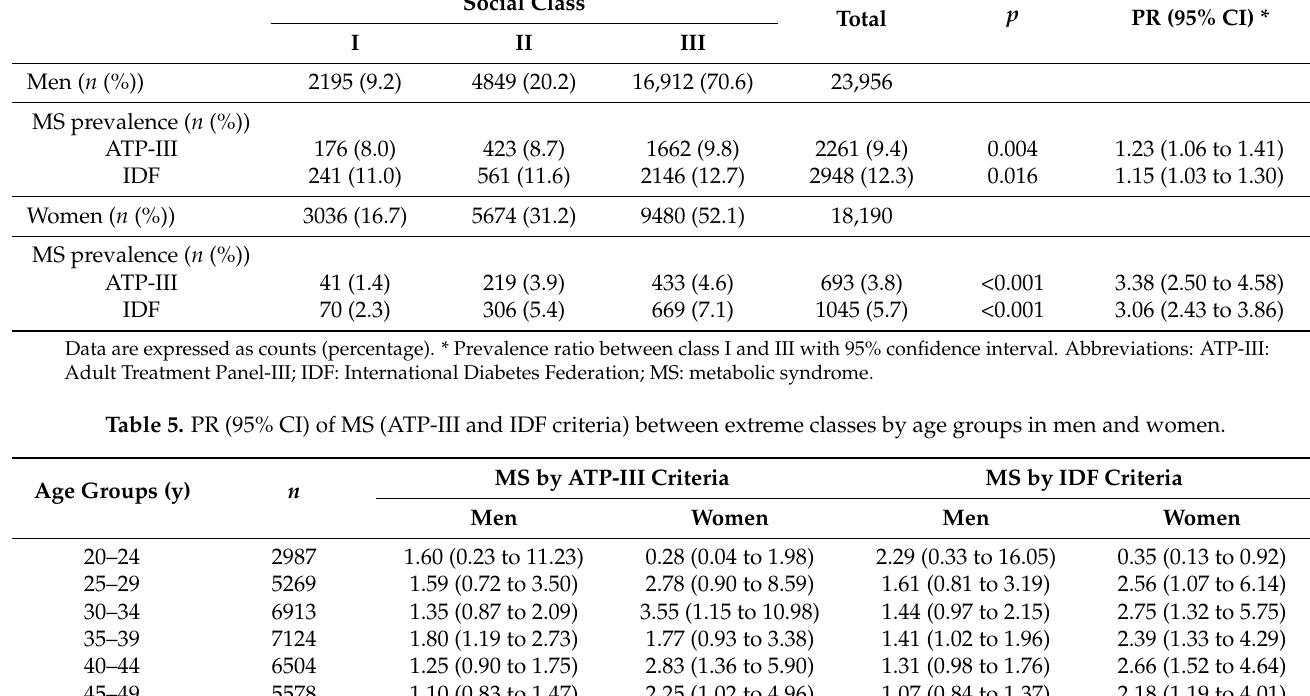
Table 4. Metabolic syndrome prevalence according to the ATP-III and the IDF criteria, stratified by social class in men and women.